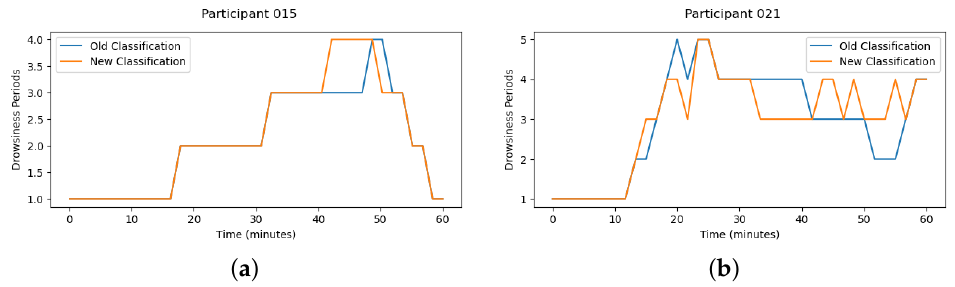
Figure 9. Drowsiness Classification Improvements. ( a ) participant 15. ( b ) participant 21.